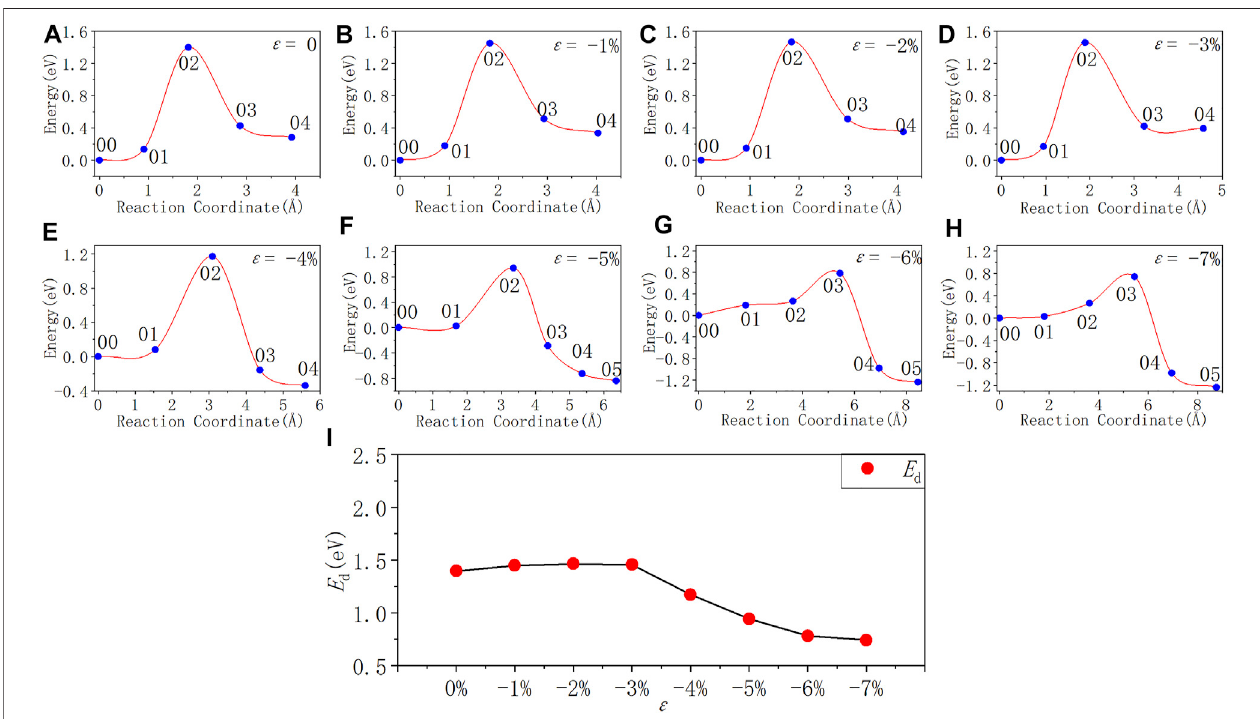
FIGURE 7 | Reaction energy curves and activation energy pro fi le curve ofthe P b defect depassivation; (A – H) exhibit depassivation reaction energy curves under a compressive strain range of 0%~ − 7%, and (I) exhibits the activation energy pro fi le curve.